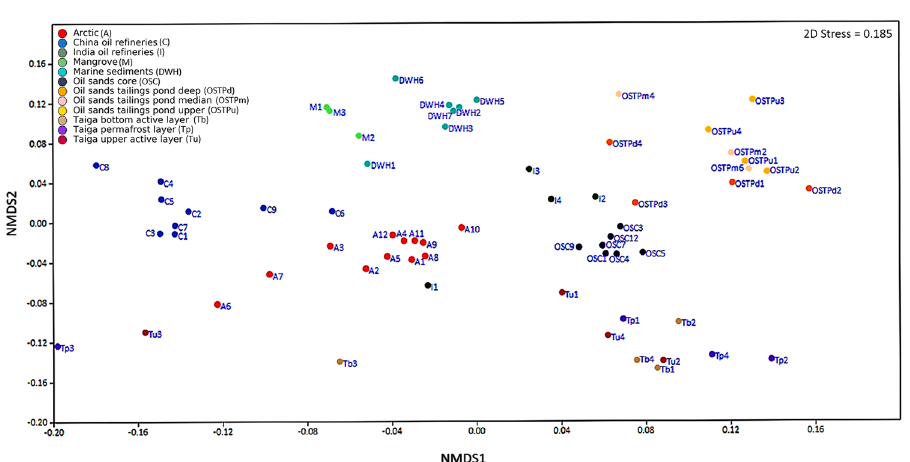
Figure 2. Non-metric multidimensional scaling (NMDS) plot of taxonomic composition of all oil contaminated samples of all habitats. NMDS ordination of 65 oil contaminated samples across 12 habitats was carried out based on Bray-Curtis similarity distances calculated from pairwise taxonomic profile comparisons between all samples. Taxonomic clades present in at least one sample at a relative abundance ≥ 0.5% were used as input. A shorter linear distance between two samples denote greater similarity between the corresponding samples. Samples from 12 environments are depicted by different colors (see